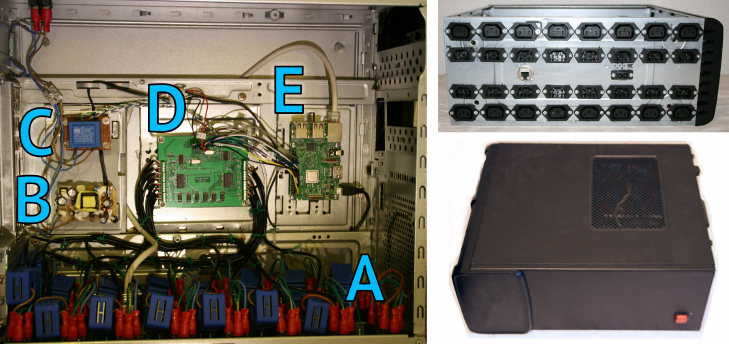
Figure 9. Prototype. Left side: internal view (A sensors zone, B power supply, C AC transformer, D designed PCB, E Raspberry Pi 3), top right: rear view, bottom right: front